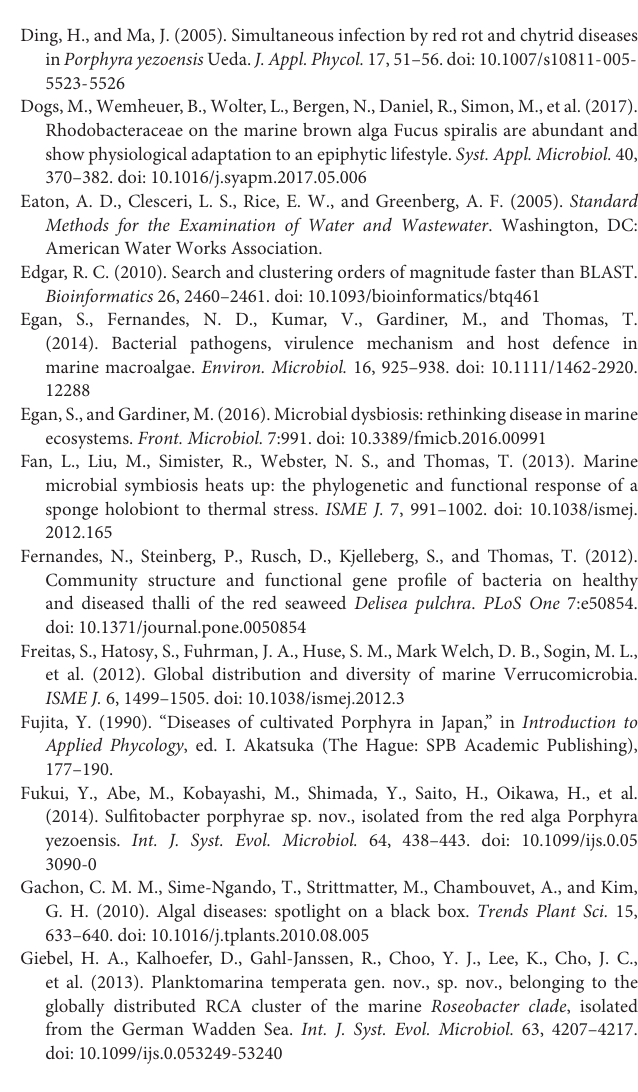
FIGURE S1 | Venn diagrams showing the total number of OTUs and the number of shared OTUs across all Pyropia yezoensis (A) and seawater (B) datasets. FIGURE S2 | Rarefaction curves of Pyropia yezoensis and seawater datasets by (A) Good’s coverage, (B) Observed species, (C) Chao1, (D) PD, and (E) Shannon with OTU being defined at 97% sequence similarity. FIGURE S3 | Distribution of the most abundant 30 OTUs across the Pyropia yezoensis (A) and seawater (B) datasets. Colors represent the relative abundance of each